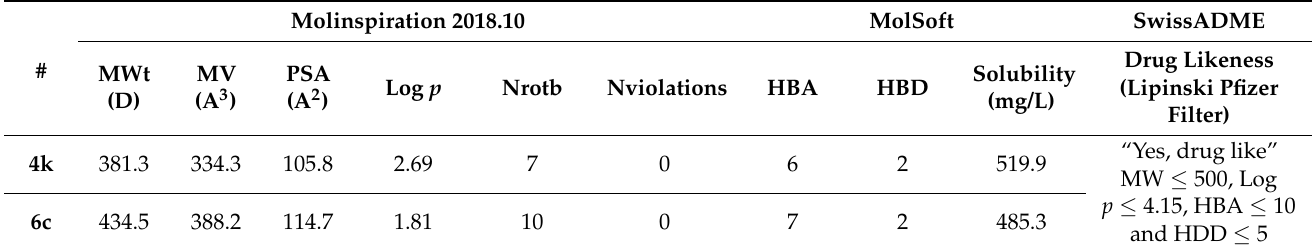
Table 2. In silico ADME pharmacokinetics properties of the lead compounds. Molinspiration 2018.10